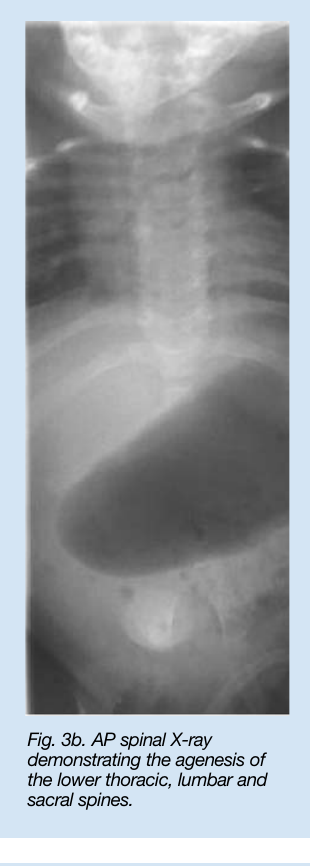
Fig. 3b. AP spinal X-ray demonstrating the agenesis of the lower thoracic, lumbar and sacral spines.